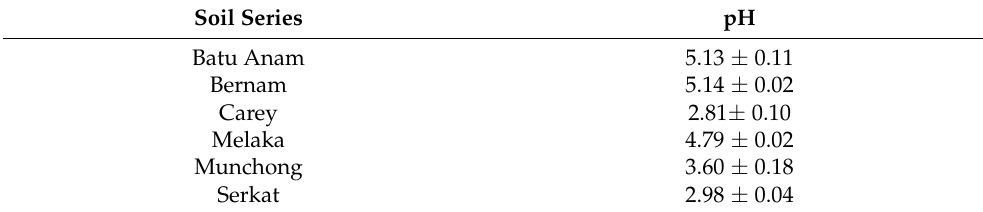
Table 3. pH values of untreated clay leachates obtained from six soil